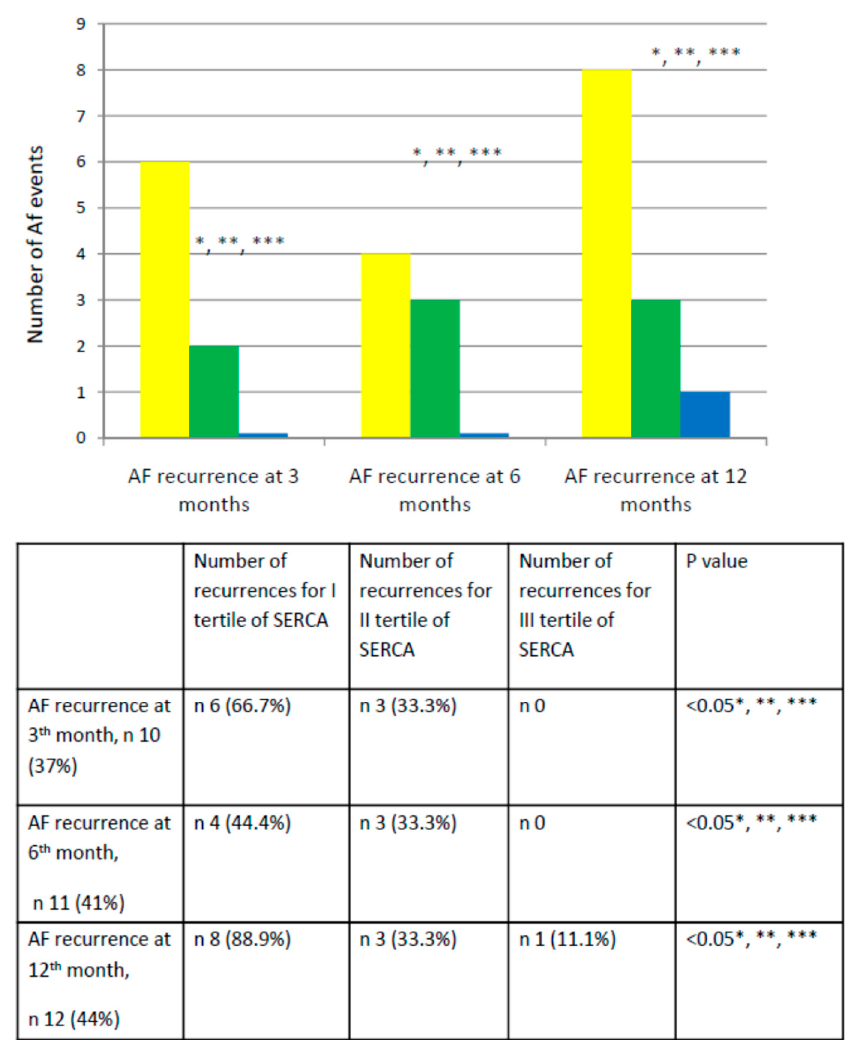
Figure 2. In the upper part of the figure, the number of atrial fibrillation (AF) recurrence for 3, 6, and 12 months of follow-up in study population divided for tertiles of sarcoplasmic endoplasmic reticulum calcium ATPase (SERCA) values and arranged by columns for number of events in ascending order (in yellow the I tertile of SERCA, in green the II tertile, and in blue the III tertile). In the lower part of figure, the table to report the number (n) of AF recurrences for I, II, and III tertile of SERCA values. The symbol “*” is for p < 0.05, comparing I tertile vs. II tertile of SERCA; the symbol “**” is for p < 0.05, comparing I vs. III tertile of SERCA; the symbol “***” is for p < 0.05, comparing II vs. III tertile of SERCA.